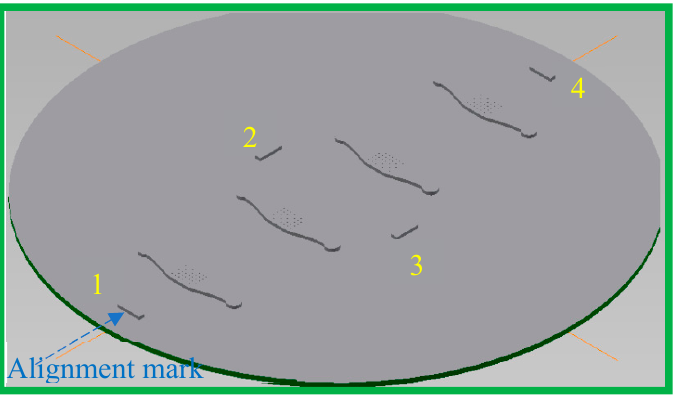
Figure 7. Injection moulding shim design with four alignment marks. The injection point is approximately at position 1 in the injection moulding machine.